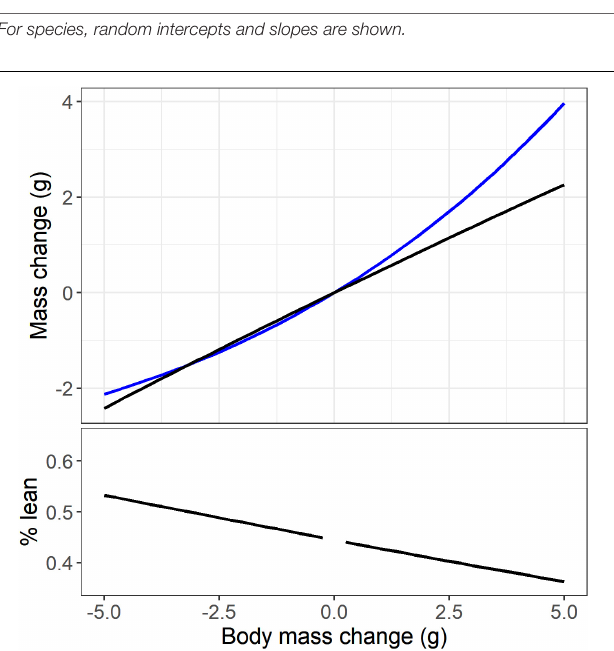
FIGURE 6 | Scaling of lean mass with body mass for 3 species of songbirds stopping over at Long Point, Ontario, highlighting differences between age classes in autumn. The lines show the linear mixed model predictions for juvenile (blue) and adult (orange) birds when year = 2009. Species codes are defined in Table 1